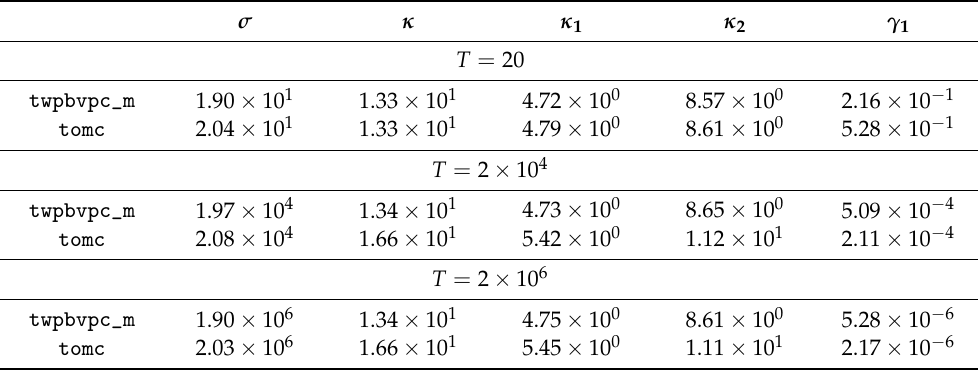
Table 5. Nonlinear Mass spring: conditioning parameters computed using tol = 10 − 6 and initial mesh with 11 equidistant points.